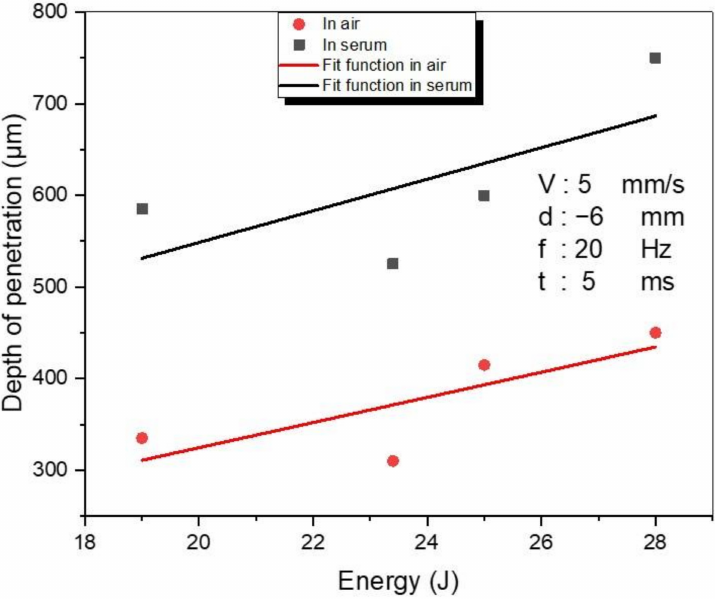
Figure 10. The variations in the penetration depth ( µ m) with energy.